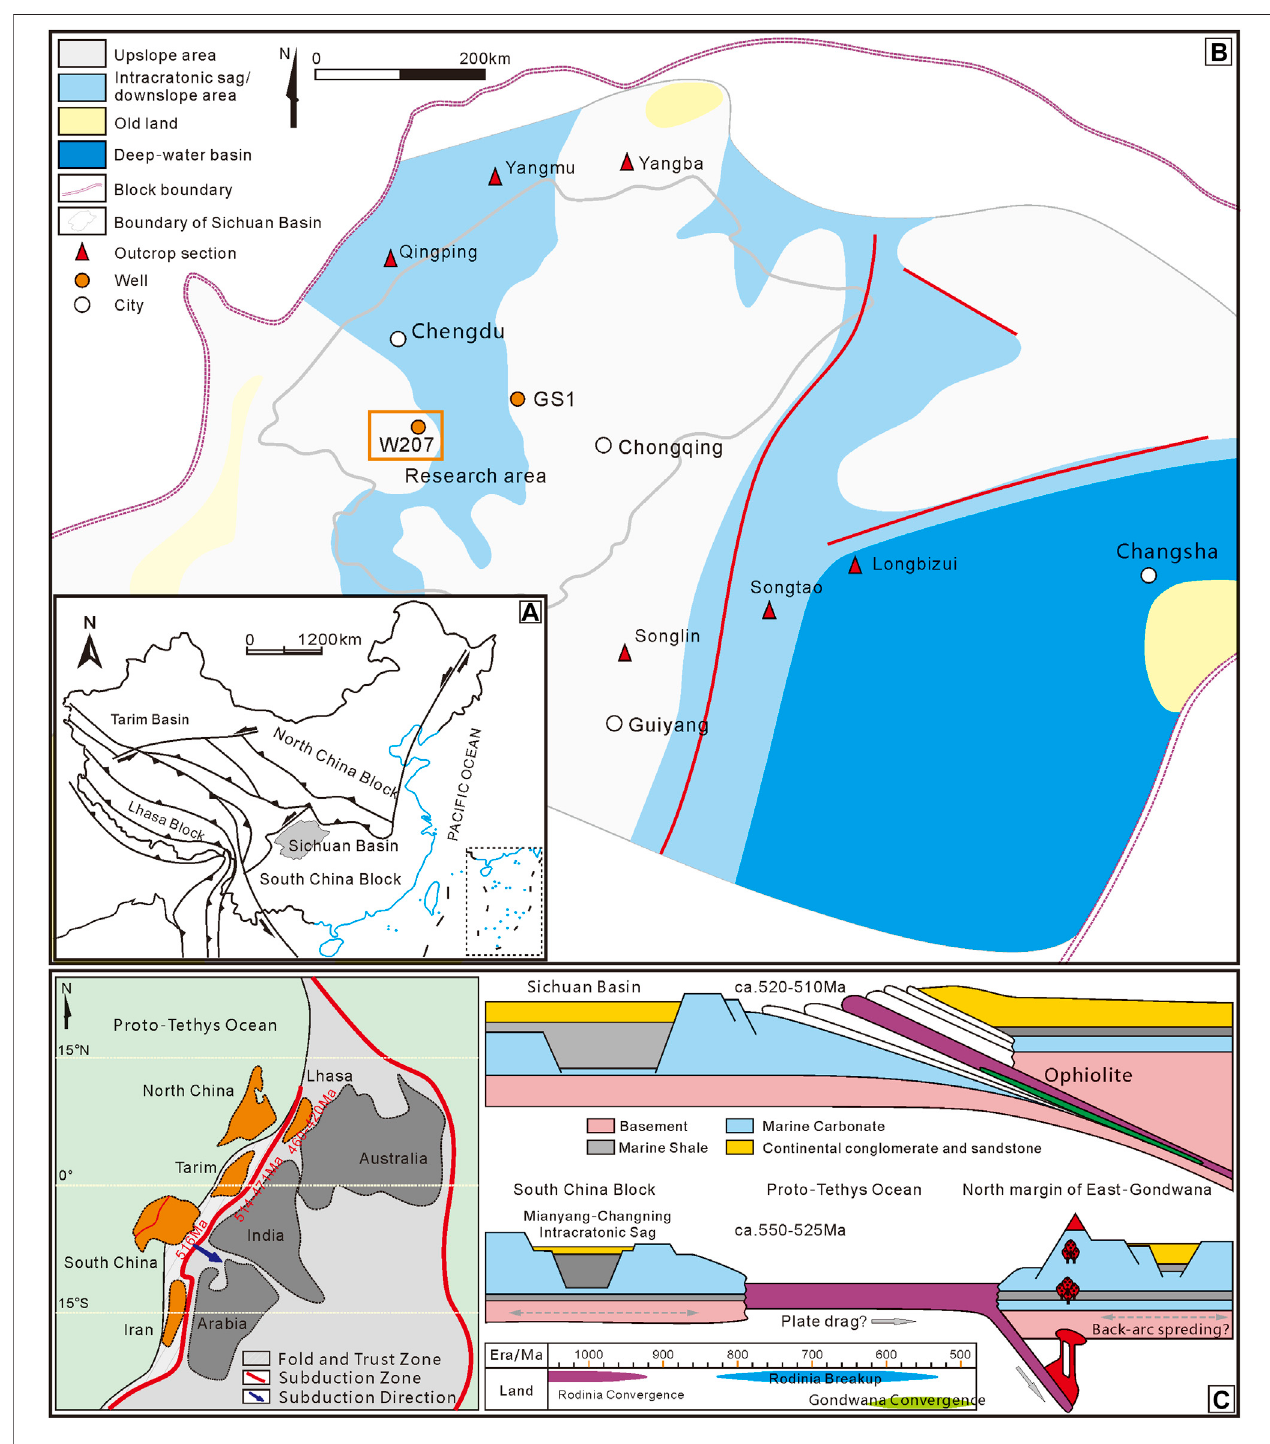
FIGURE1|(A) Simpli fi edmapofChinathatshowsthelocationoftheSichuanBasin(gray),SouthChinaBlock. (B) Early-Cambriantectonicpaleogeographyofthe Upper Yangtze Region (modi fi ed from Li et al., 2019 and Ding et al., 2021). The W207 Well is located at west side of Mianyang-Changning Intracratonic Sag. (C) Aggregation kinetic model between Yangtze and Gondwana (Arabia) in the Early Paleozoic.